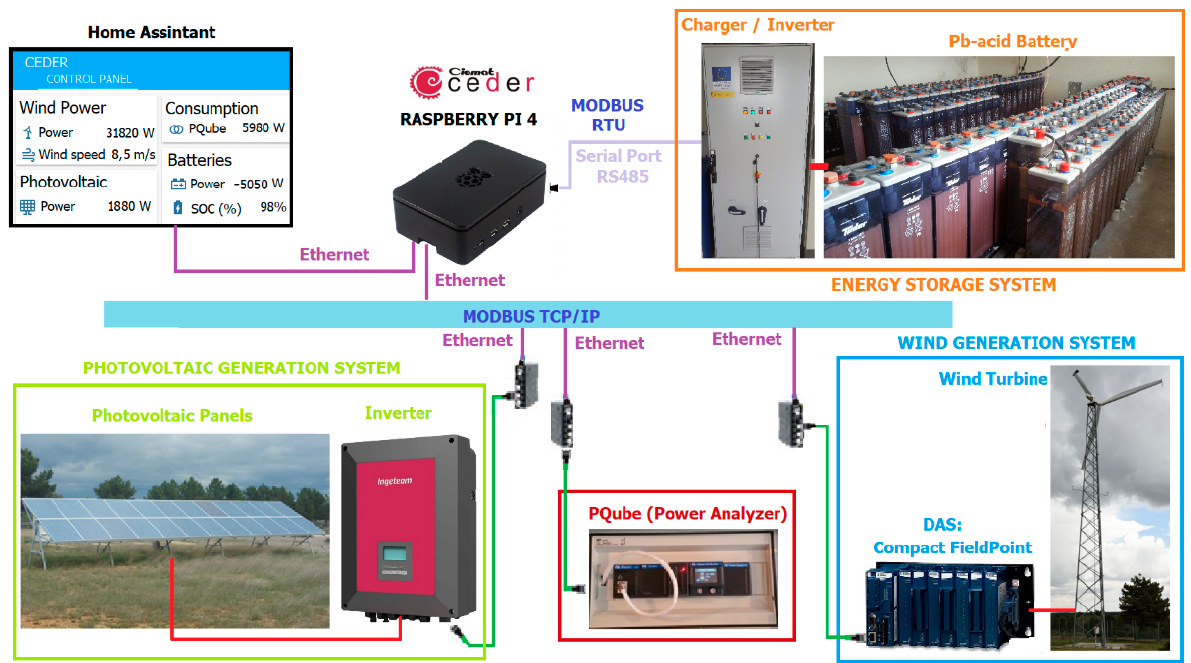
Figure 6. Elements of the CEDER’s microgrid. Source: prepared by authors. To communicate between each element (photovoltaic panels, wind turbine, Pb-acid batteries, and loads) with Home Assistant, and monitoring and recording required infor- mation, we have to proceed as seen in step 3, Section